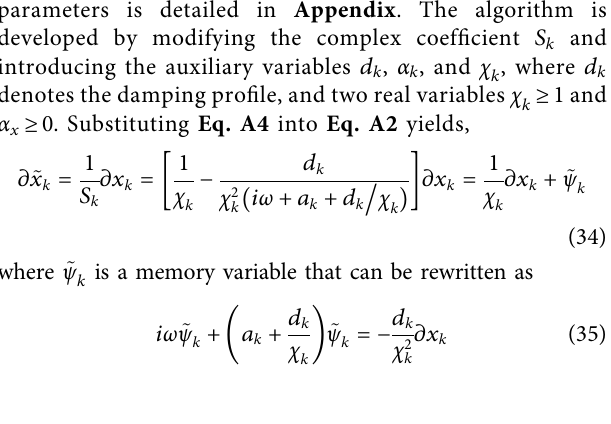
Frontiers in Earth Science |